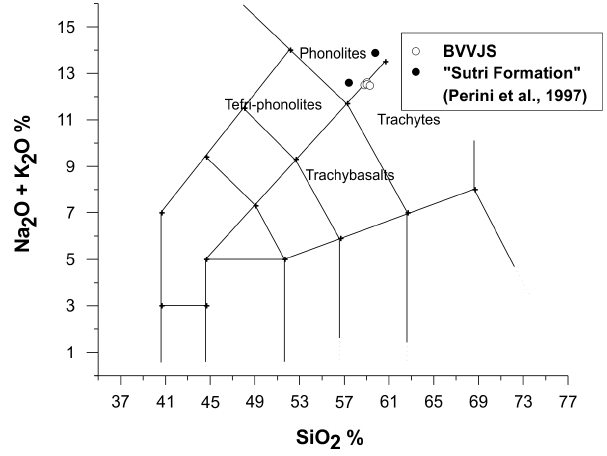
Figure 3. Total alkali silica diagram after Le Maître